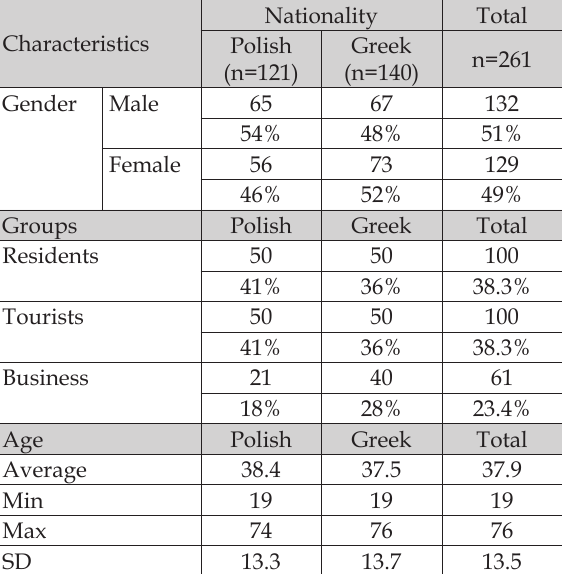
Table 1. Respondents’ demographic and socioeco